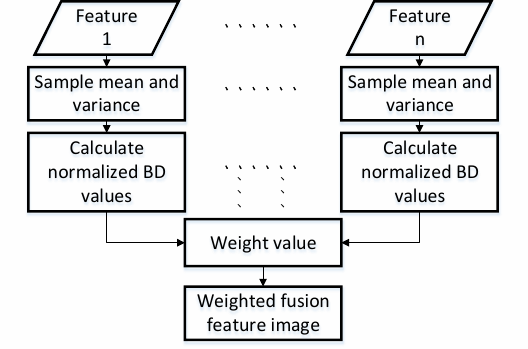
Figure 2 Multi feature weighted fusion